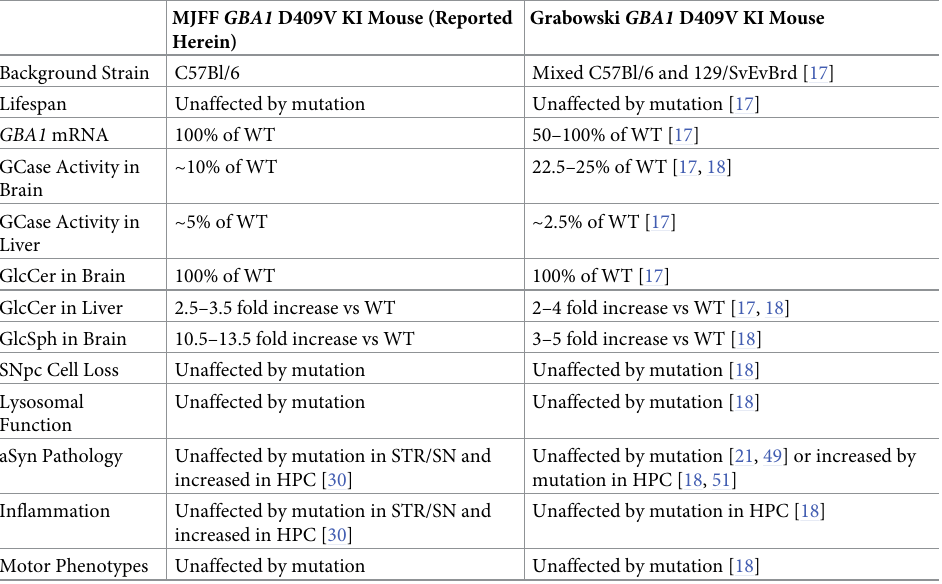
Table 2. Phenotype comparisons between different homozygous GBA1 D409V KI mouse models.